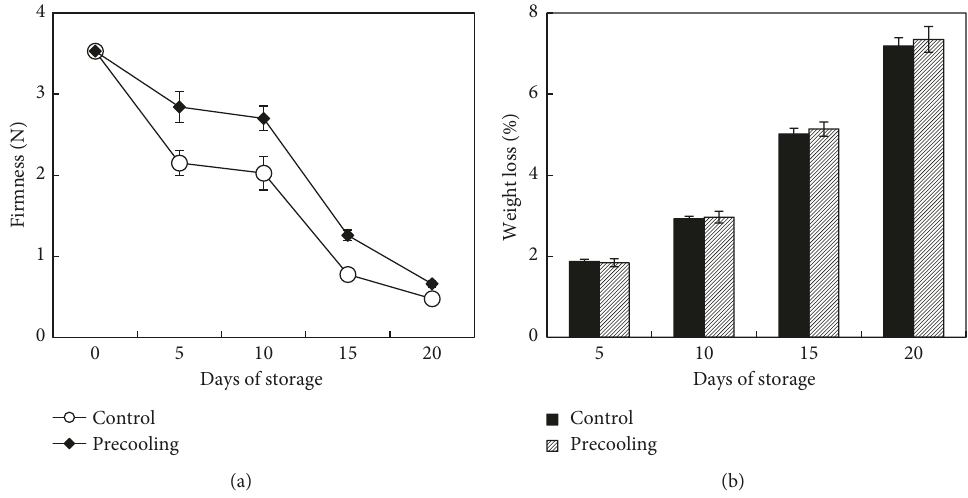
Figure 1: Effects of forced air precooling treatment on firmness (a) and weight loss (b).